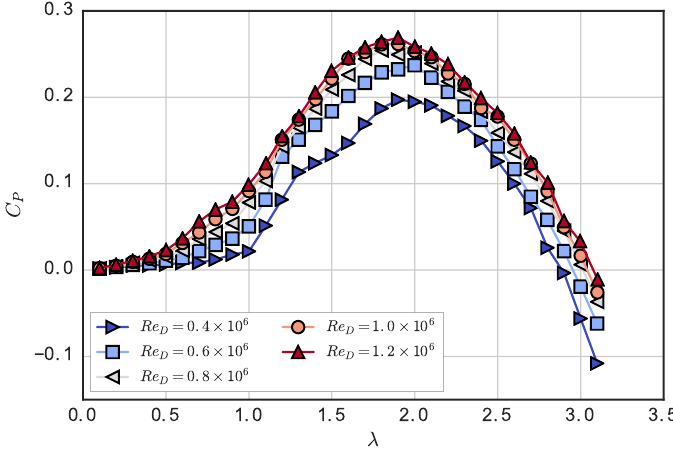
Figure 4. Mean power coefficient curves plotted for multiple Reynolds numbers.